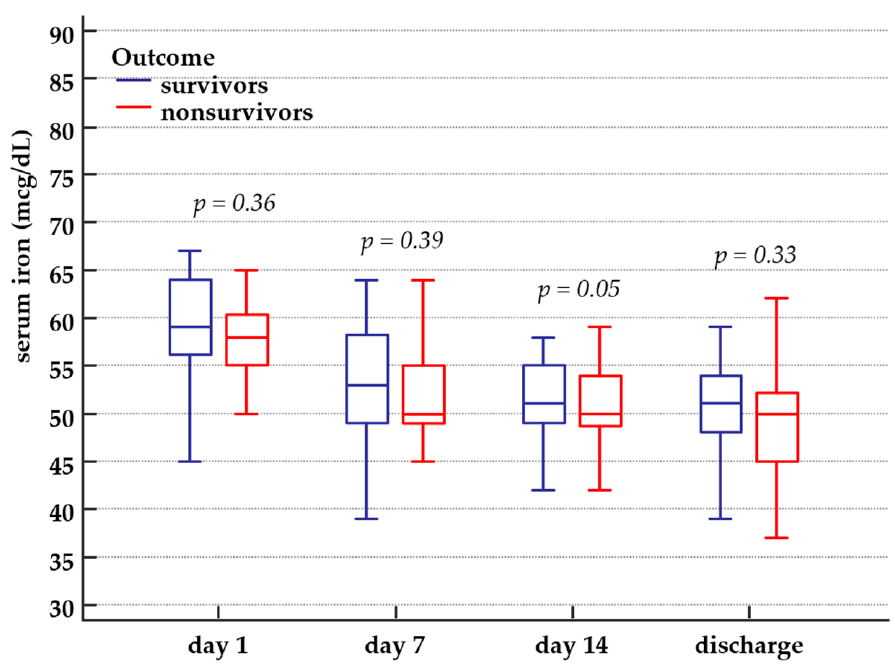
Figure 2. Serum iron dynamics in survivors and nonsurvivors. Serum iron minimum and maximum value, interquartile range and median value in survivors and nonsurvivors, from ICU day 1 until hospital discharge or in-hospital death.